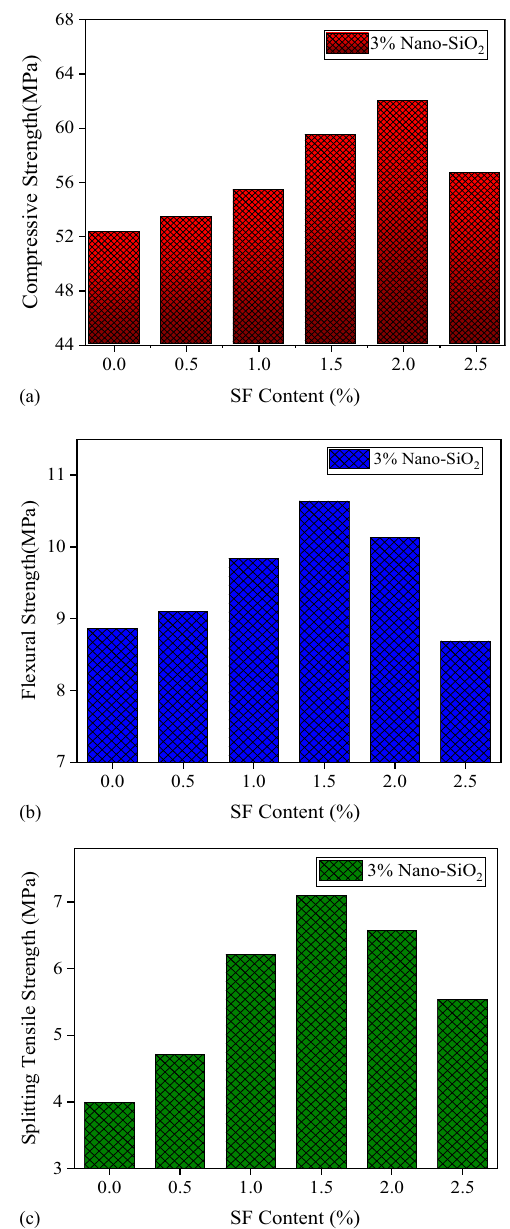
Figure 7: E ff ect of SF on mechanical strengths: ( a ) compressive strength, ( b ) fl exural strength, and ( c ) splitting tensile